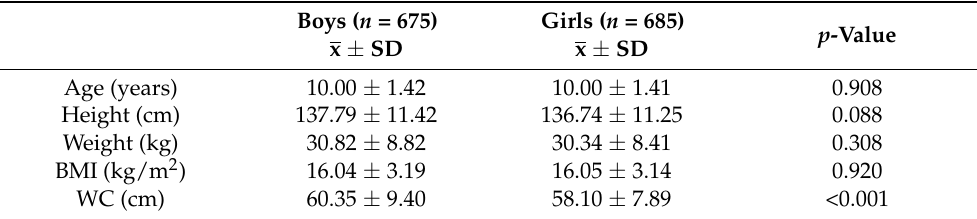
Table 2. Descriptive statistics for demographic and anthropometric characteristics of